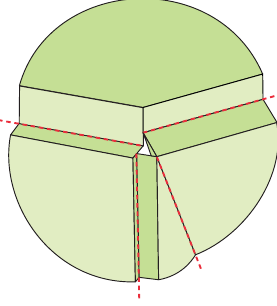
Figure 2. Chen et al. (2015) demonstrates a thickness accommo- dation method which uses spatial linkages at the vertices of the origami pattern to achieve its motion. A single origami vertex is shown that employs such a mechanism. This illustration is sep- arate because the method cannot be portrayed in the same two- dimensional form as the other methods. The red dotted lines indicate the rotational axes. This method was shown to work with degree-4, degree-5, and degree-6 vertices.